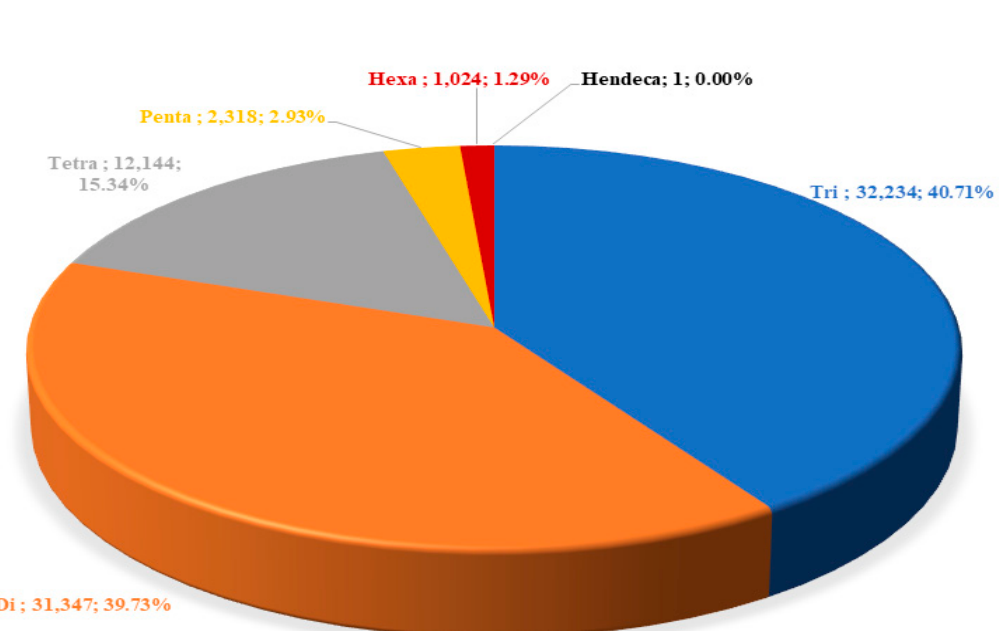
Figure 5. Simple sequence repeats (SSRs) detected in the 32 Durio zibethinus L. genotypes. ( A ). Frequency of amplicon lengths from the SSRs detected in the 32 durian genotypes. ( B ). Types of SSRs detected.